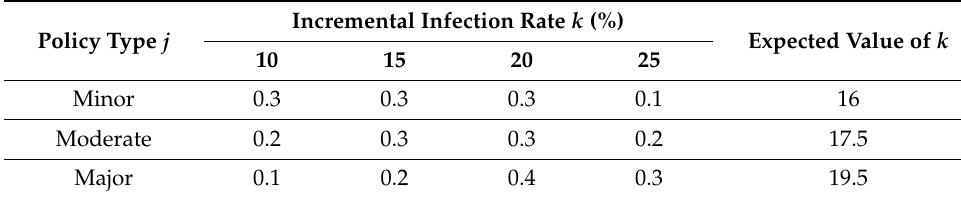
Table 7. Scenario 2: probabilities of incremental infection rates by policy type.